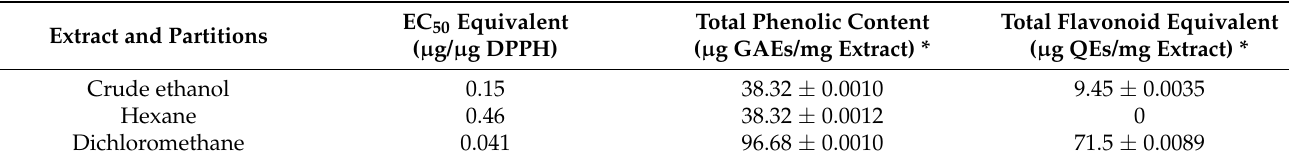
Table 2. EC 50 values, EC 50 equivalent, total phenolic content and total flavonoid content of the crude ethanol extract of Elsholtzia ciliata and its fractions in hexane, dichloromethane, ethyl acetate and n-butanol. Extract and Partitions